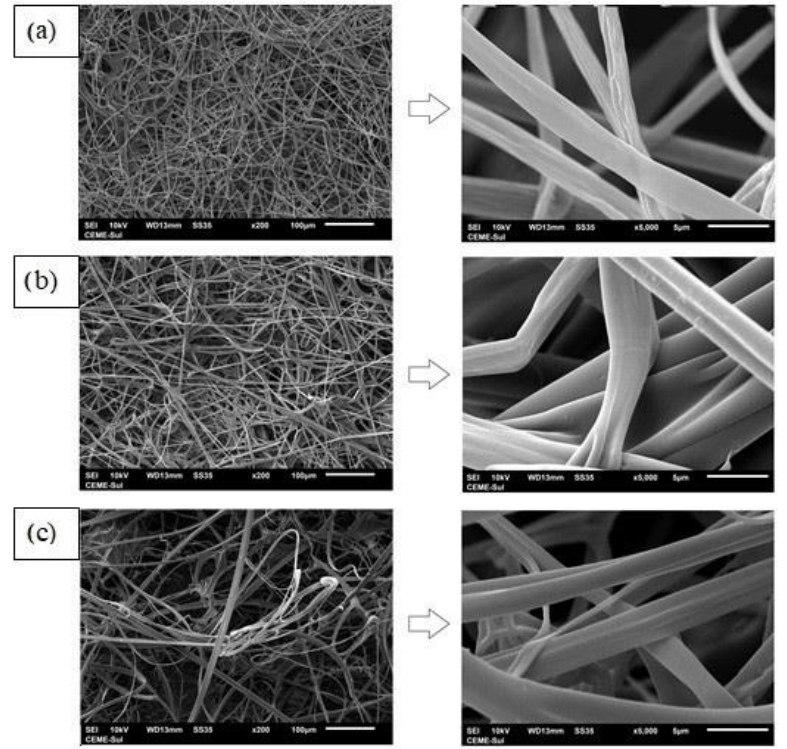
Figure 3. Morphology of zein fiber ( a ), chitosan/zein fiber ( b ) and chitosan/zein fiber + 3% of JPE ( c ). JPE: jaboticaba peel extract.